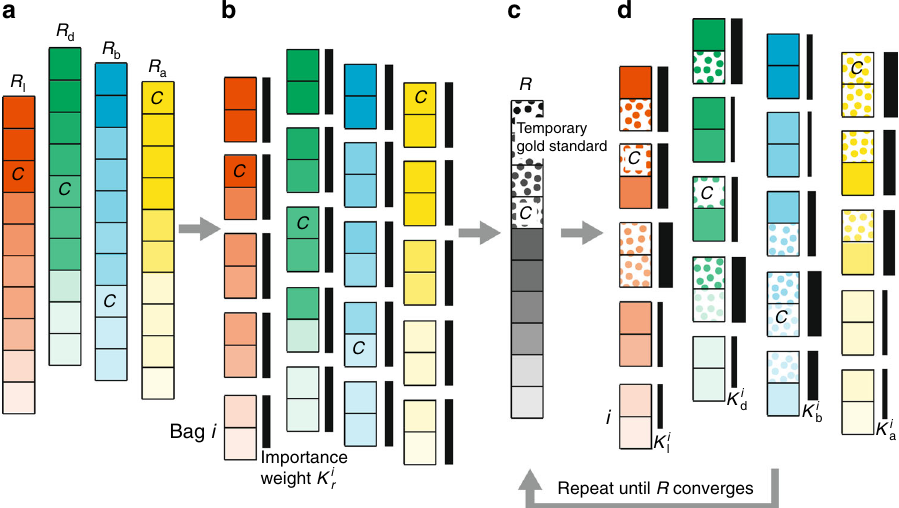
Fig. 5 Combining community prioritization metrics without an external gold standard. a The rank aggregation algorithm starts with four ranked lists of communities, R r , each one arising from the values of a different community prioritization metric r (where r is one of “ l ”— likelihood, “ d ”— density, “ b ”— boundary, “ a ”— allegiance). Communities are ordered by the decreasing value of the metric. We use C to indicate the rank of an illustrative community by the community prioritization metrics and at different stages of the algorithm. b Each ranked list is partitioned into equally sized groups, called bags. Each bag i in ranked list R r has attached importance weight K i r whose initial values are all equal (represented by black bars all of same width). CR ANK uses the importance weights K i r to initialize aggregate prioritization R as a weighted average of community ranks R l , R d , R b , R a . c The top-ranked communities (denoted as dotted cells) in the aggregated prioritization R serve as a temporary gold standard, which is then used to iteratively update the importance weights K i r . d In each iteration, CR ANK updates importance weights using the Bayes factor calculation 36 (Supplementary Note 4). Given bag i and ranked list R r , CR ANK updates importance weight K i i . Updated importance weights r , based on how many communities from the temporary gold standard appear in bag indicates